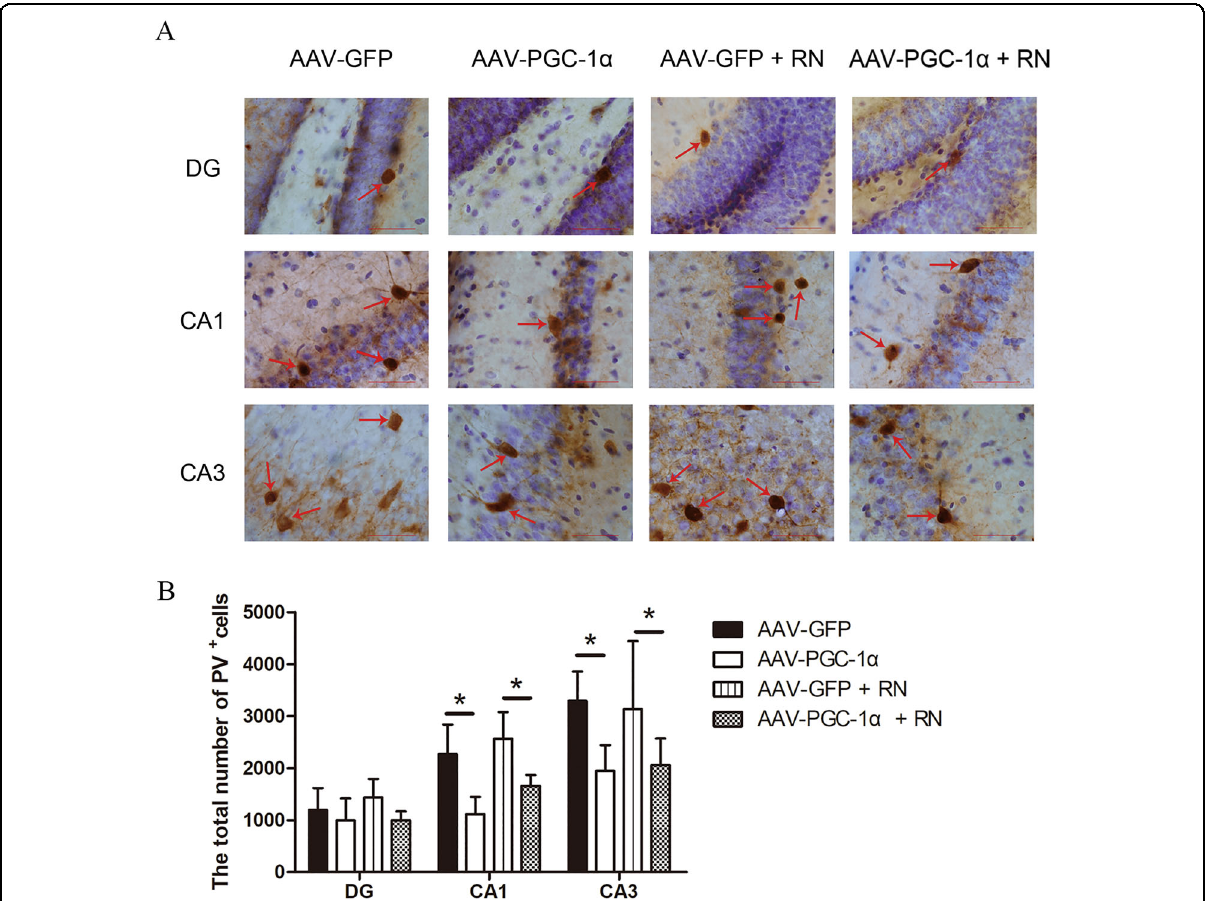
Fig. 5 Comparisons of the number of PV + interneurons in the DG, CA1, and CA3 sub fi elds of the hippocampus of the mice in different groups. A Representative pictures of immunohistochemical staining with anti-PV antibody in the hippocampus in the four groups of mice. The red arrows show the PV + interneurons. Scale bar = 40 μ m. B Quanti fi cation of PV + interneuron number in the hippocampus in the AAV-GFP group ( n = 5), AAV-PGC-1 α group ( n = 5), AAV-GFP + RN group ( n = 5) and AAV-PGC-1 α + RN group ( n = 5) of mice after immunohistochemistry staining (mean ± SD). * indicates p <